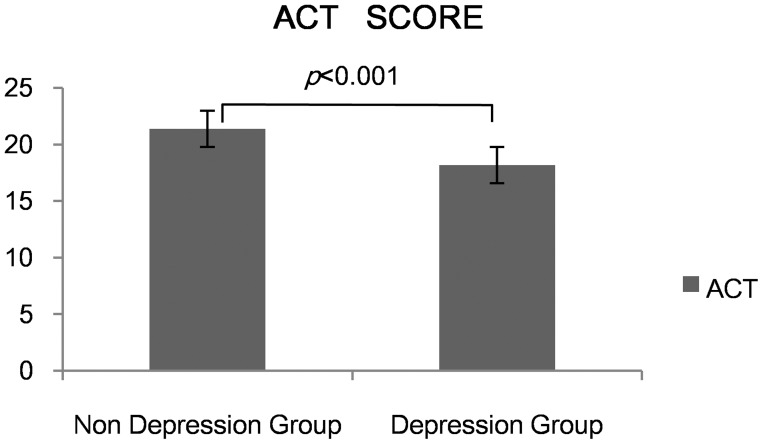
ACT score between Depression and Non depression group.